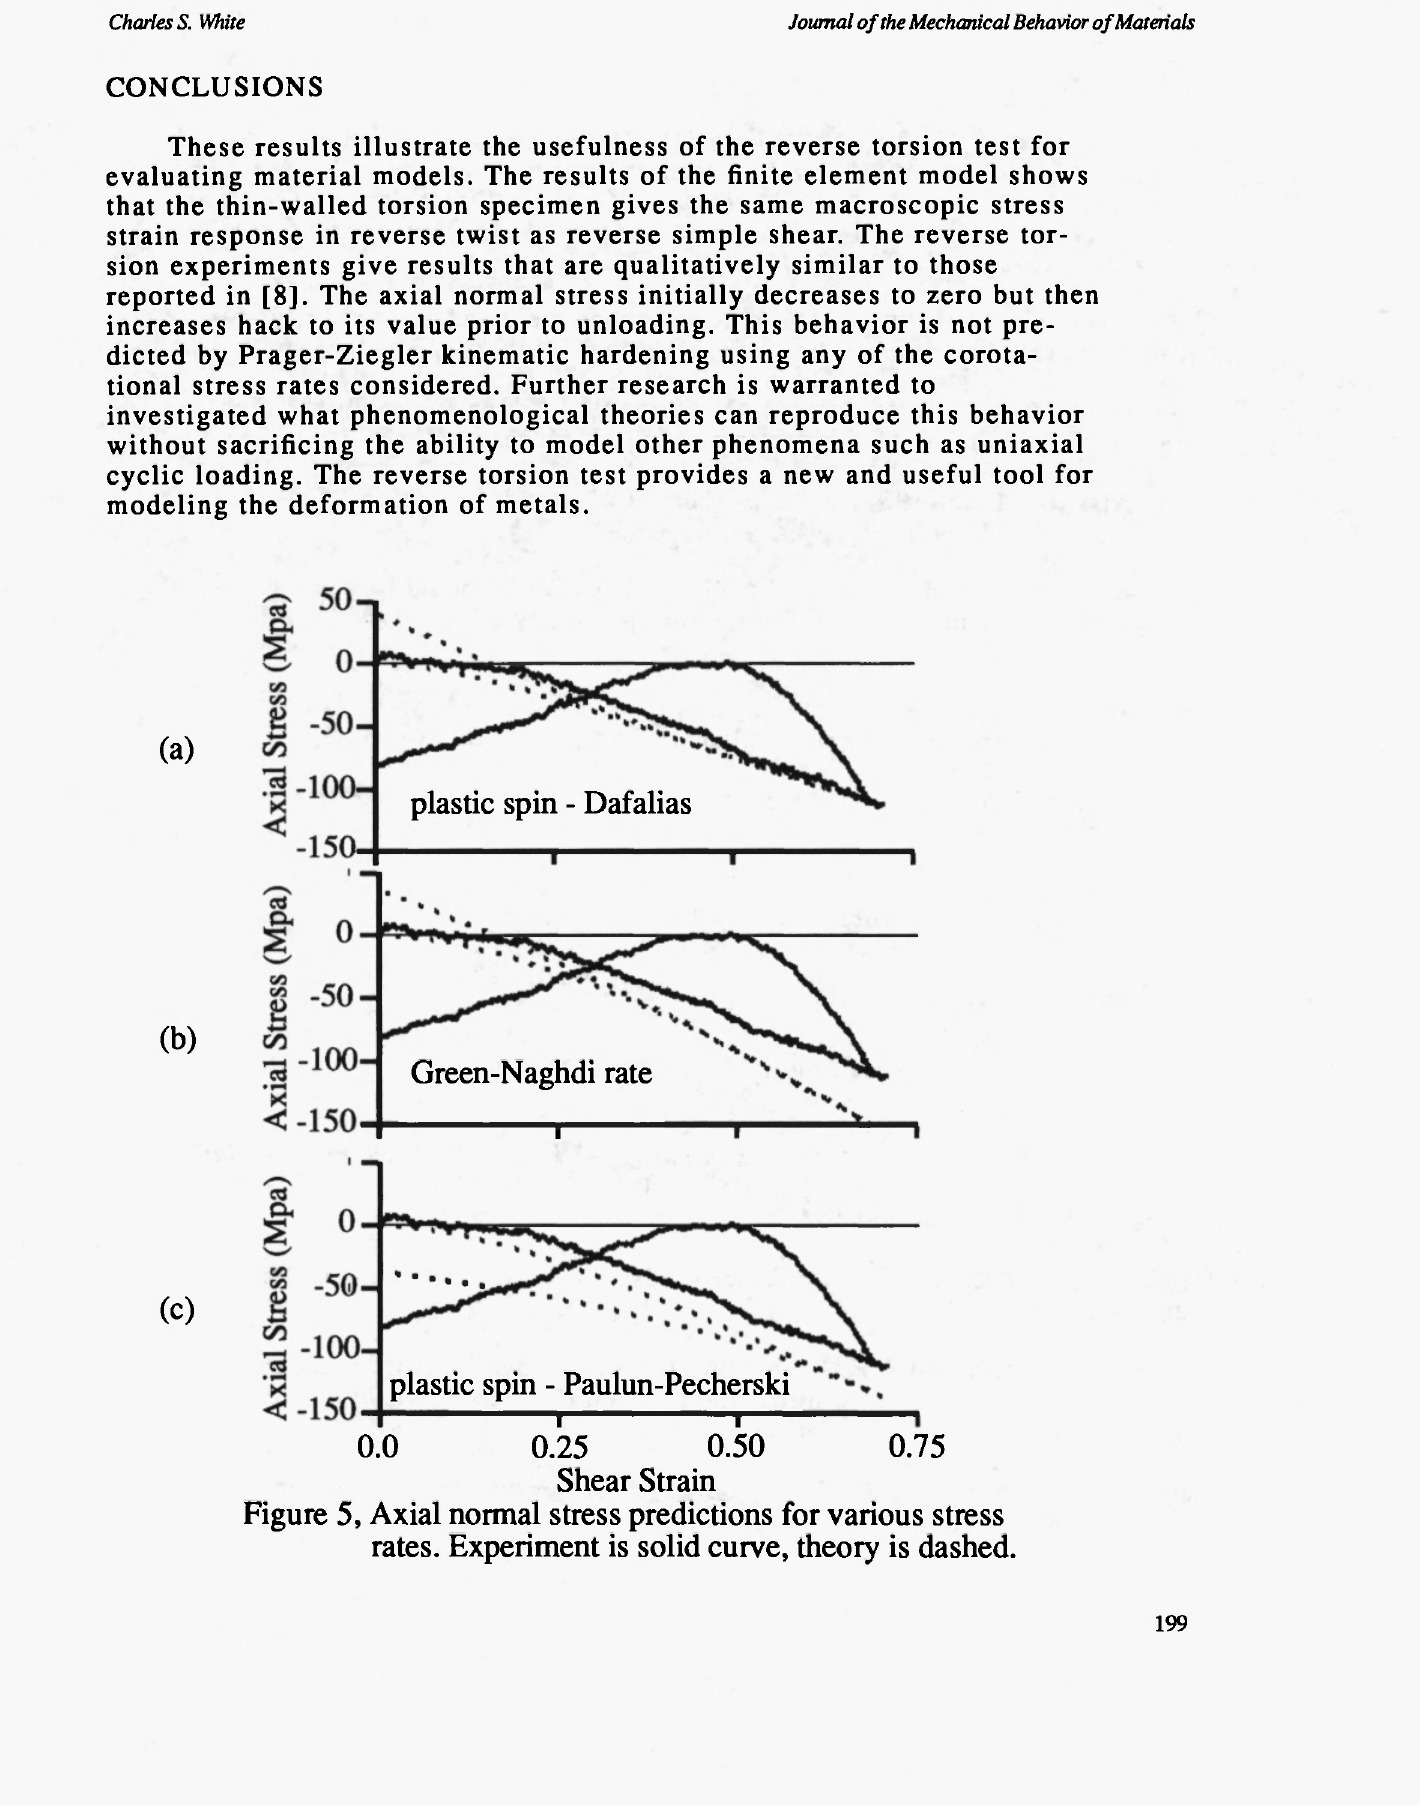
Figure 5, Axial normal stress predictions for various stress rates. Experiment is solid curve, theory is